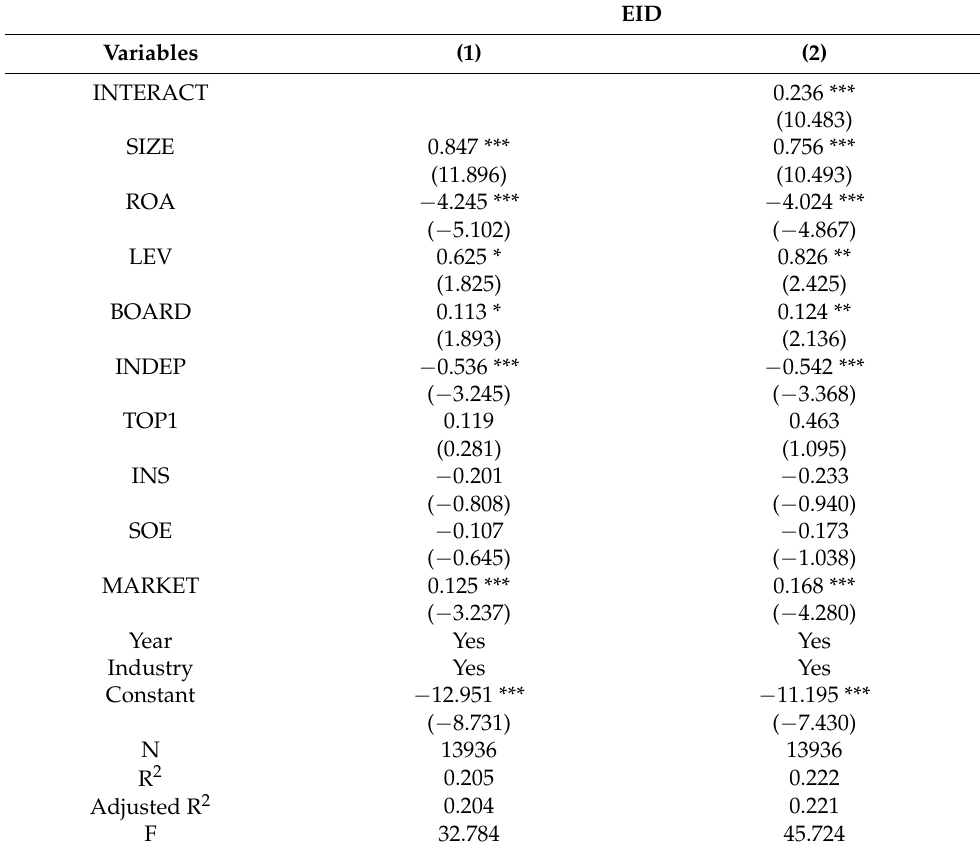
Table 4. Effect of social media interaction on